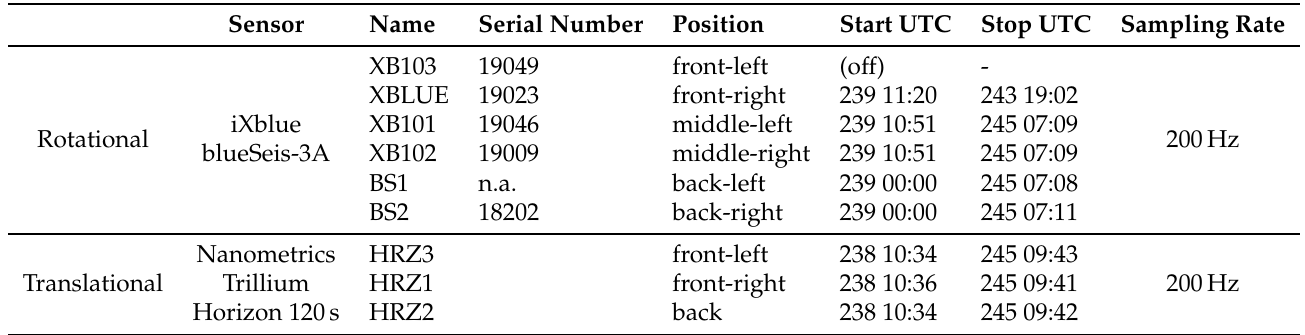
Figure 1. Sensor setup for the huddle test in the basement of the Observatory in Fürstenfeldbruck, Germany. ( a ) 3 Trillium Horizon 120s Nanometrics seismometers in left are isolated with black foam rubber and white cotton on top. 6 blueSeis-3A instruments in the middle, are linked to GPS devices in top right corner. The Quadrans is on top of XBLUE used for orientation. ( b ) Sketch of the experiment setup where 2 recording Trillium Horizon 120s Nanometrics seismometers (green HRZ1 and HRZ3), 5 recording blueSeis-3A rotational seismometers (yellow BS1, BS2, XB101, XB102 and XBLUE) and 2 not working instruments (cyan XB103 and HRZ2) are shown. Table 1. Parameters of the installed